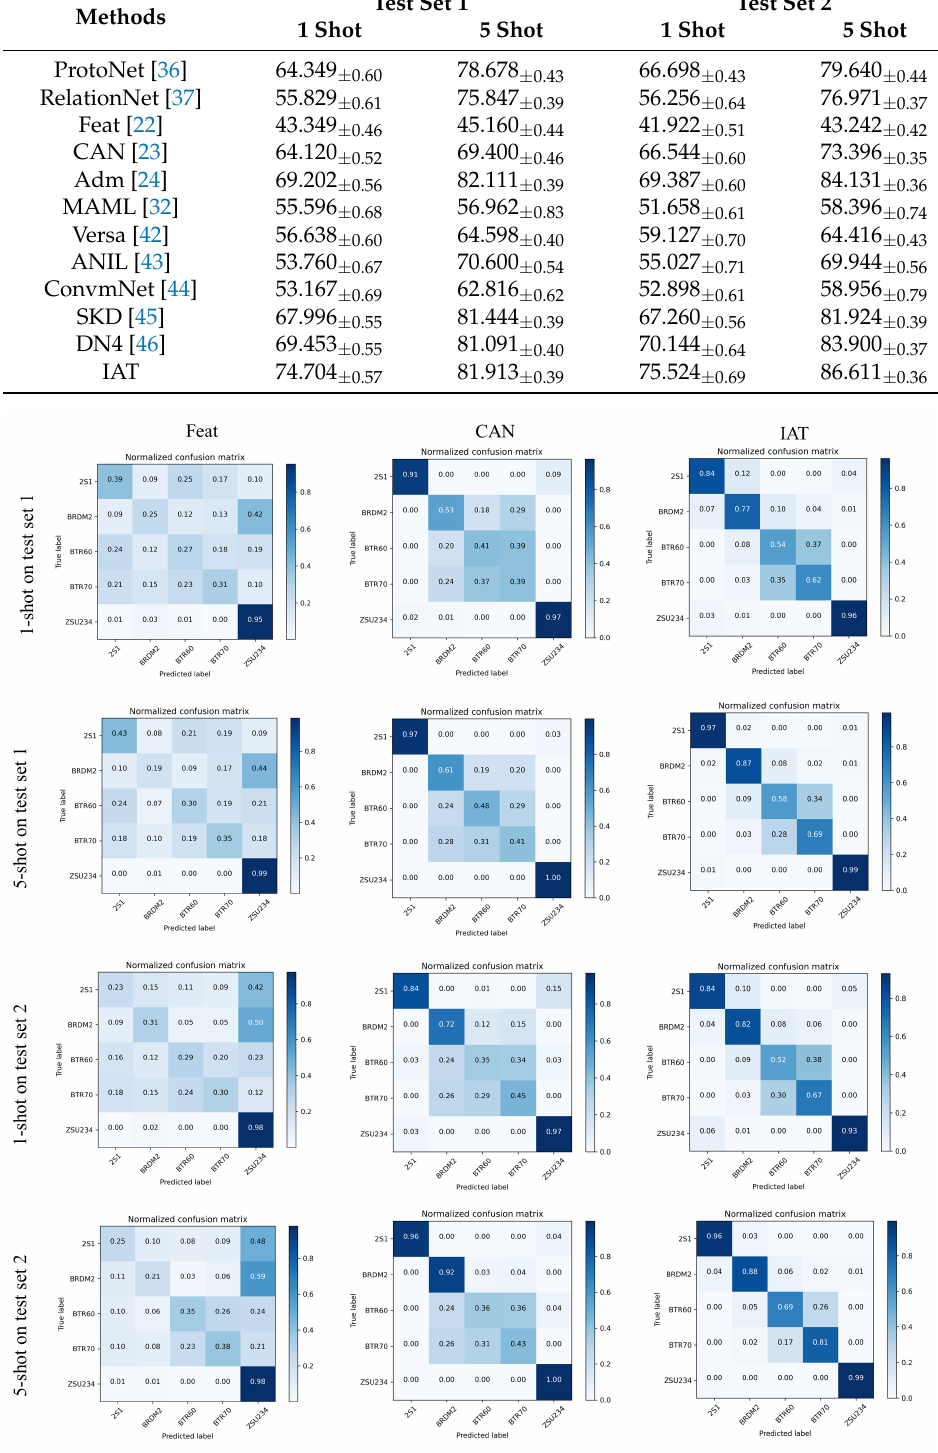
Figure 7. Confusion matrixes of Feat, CAN, and IAT on test sets 1 and 2 under 1-shot and 5- shot